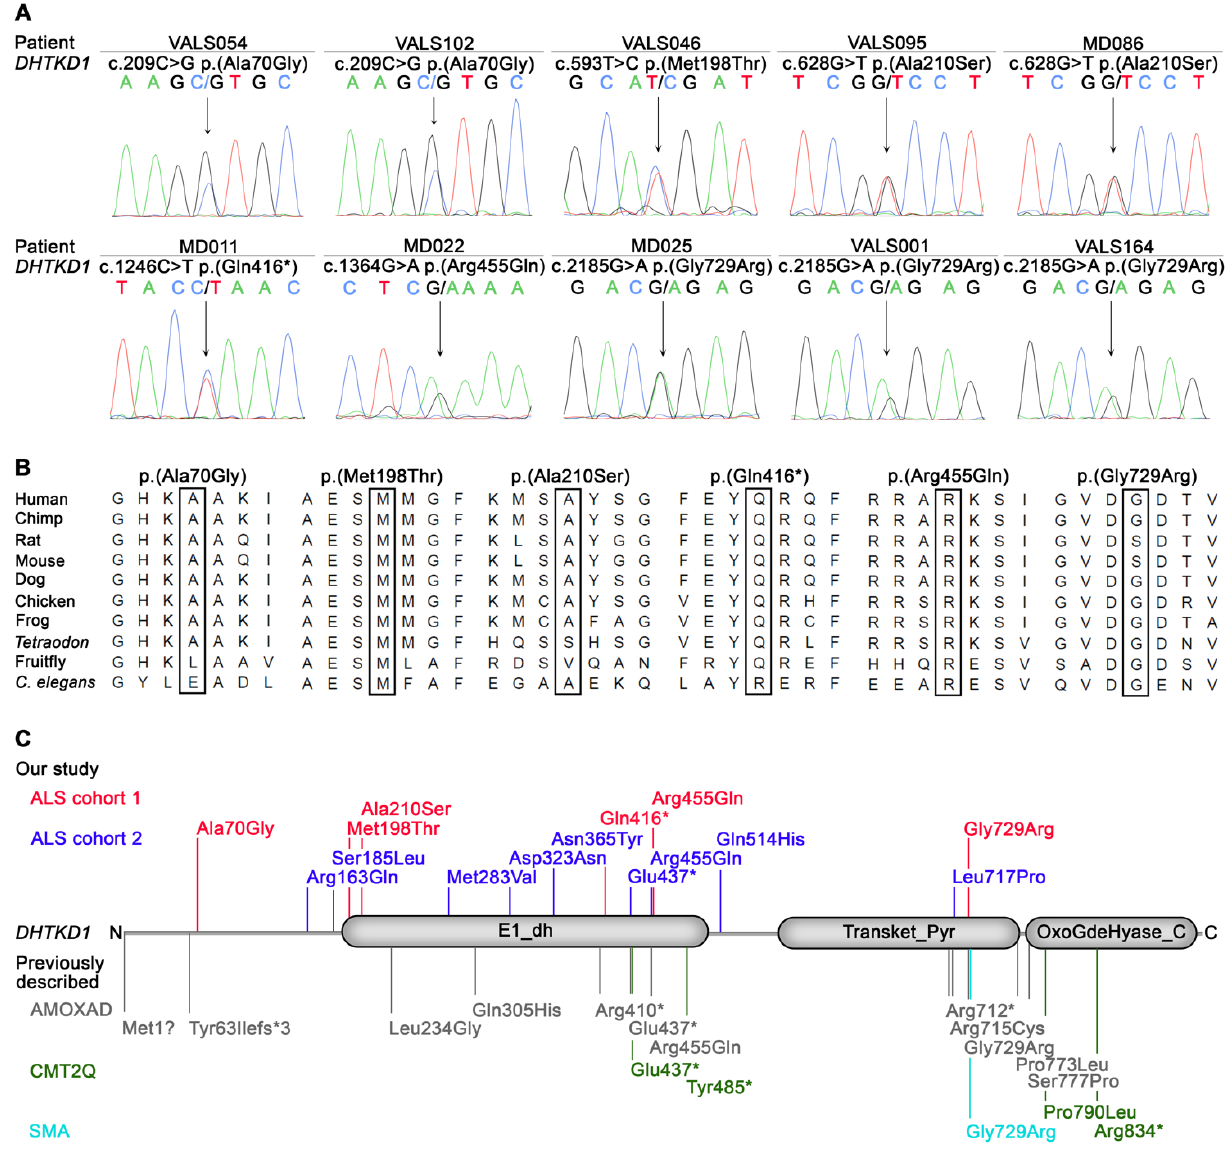
Figure 1. DHTKD1 variants identified in ALS patients of cohort 1 ( A , B ) and cohort 2 in this study, and described in other disorders previously ( C ). ( A ) Electropherograms showing the six different heterozygous rare (MAF ≤ 0.5%) DHTKD1 variants predicted to be deleterious by at least one in silico prediction tool, i.e., MutationTaster, PolyPhen-2, SIFT, or PROVEAN, detected in leukocyte DNA of 10 sporadic ALS patients of cohort 1 (affected nucleotides are highlighted by an arrow). The c.209C>G p.(Ala70Gly) and c.628G>T p.(Ala210Ser) variants were detected twice, the